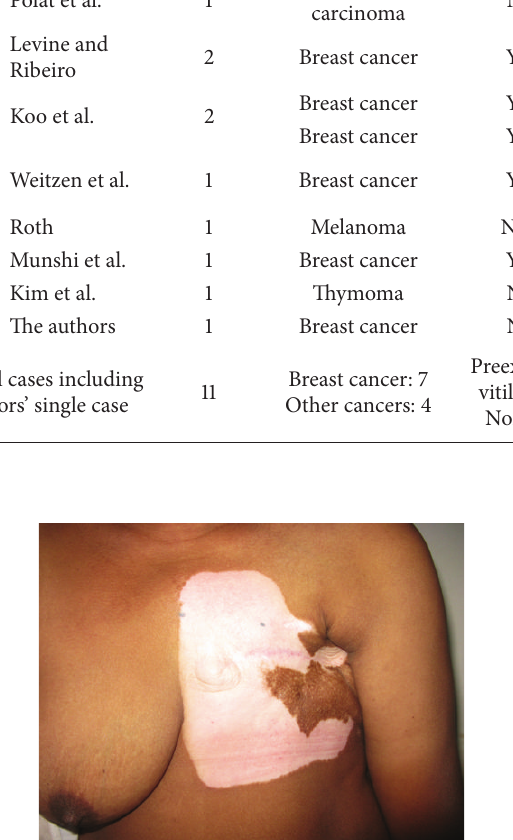
Figure 1: Authors’ case of radiation-induced new-onset vitiligo on the chest wall in irradiated area for cancer of breast. The photograph was obtained 12 months after the onset of